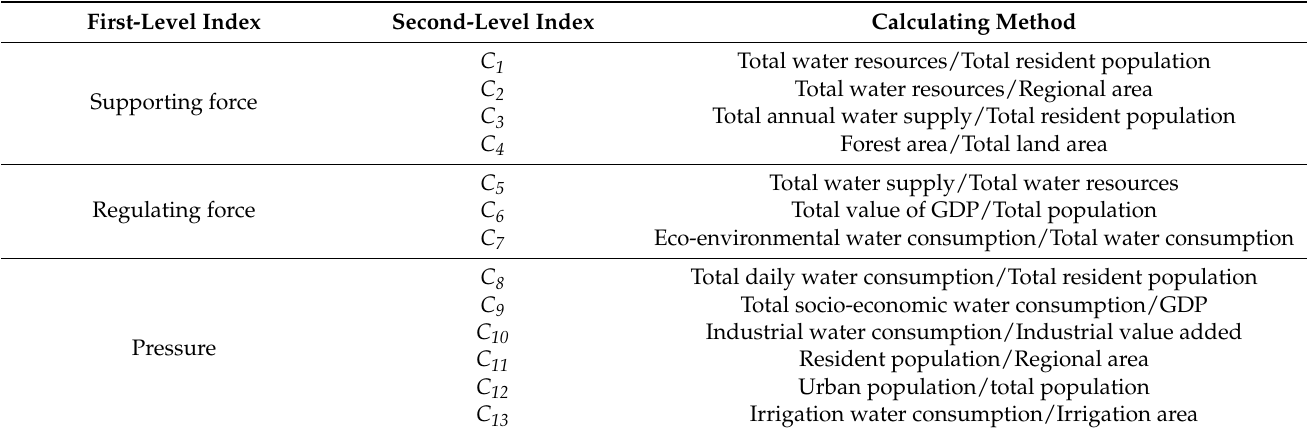
Table A1. Calculation method of each secondary index in Table